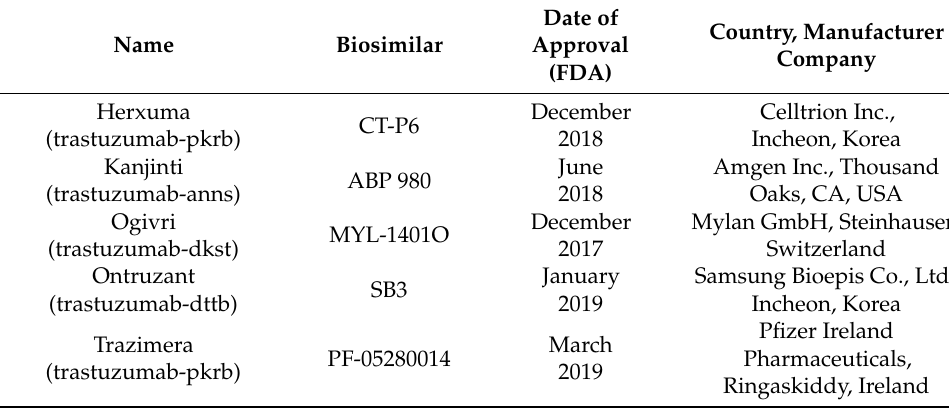
Table 3. Available and approved trastuzumab